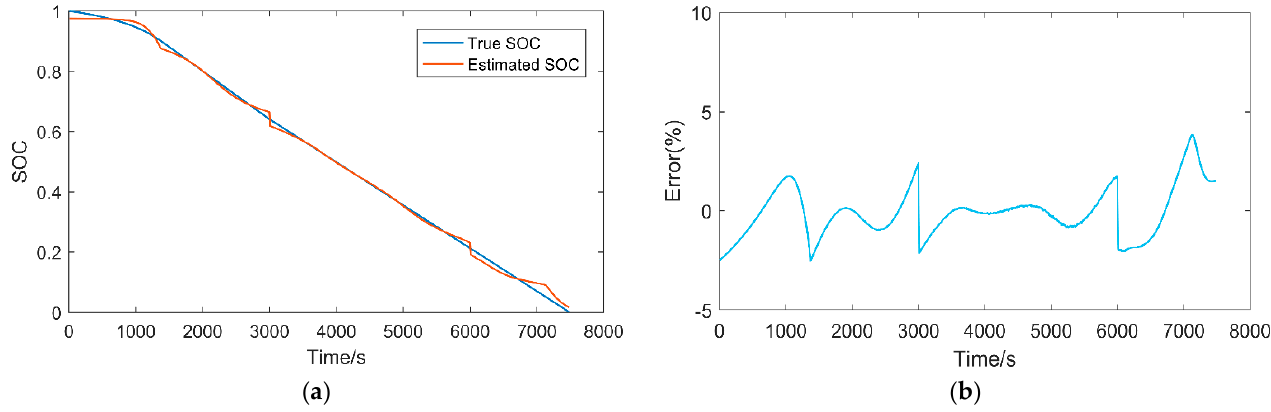
Figure 10. Estimated results of BJDST in a variable temperature environment: estimated results ( a ) and estimated errors ( b ).